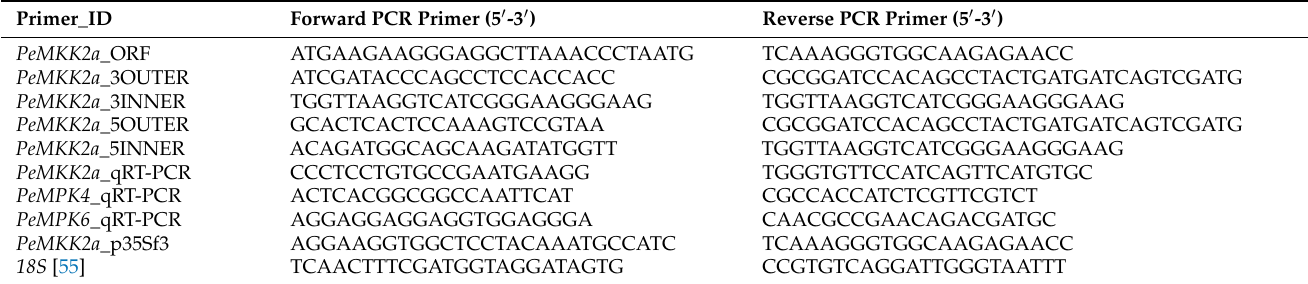
Table 1. Primers used in this